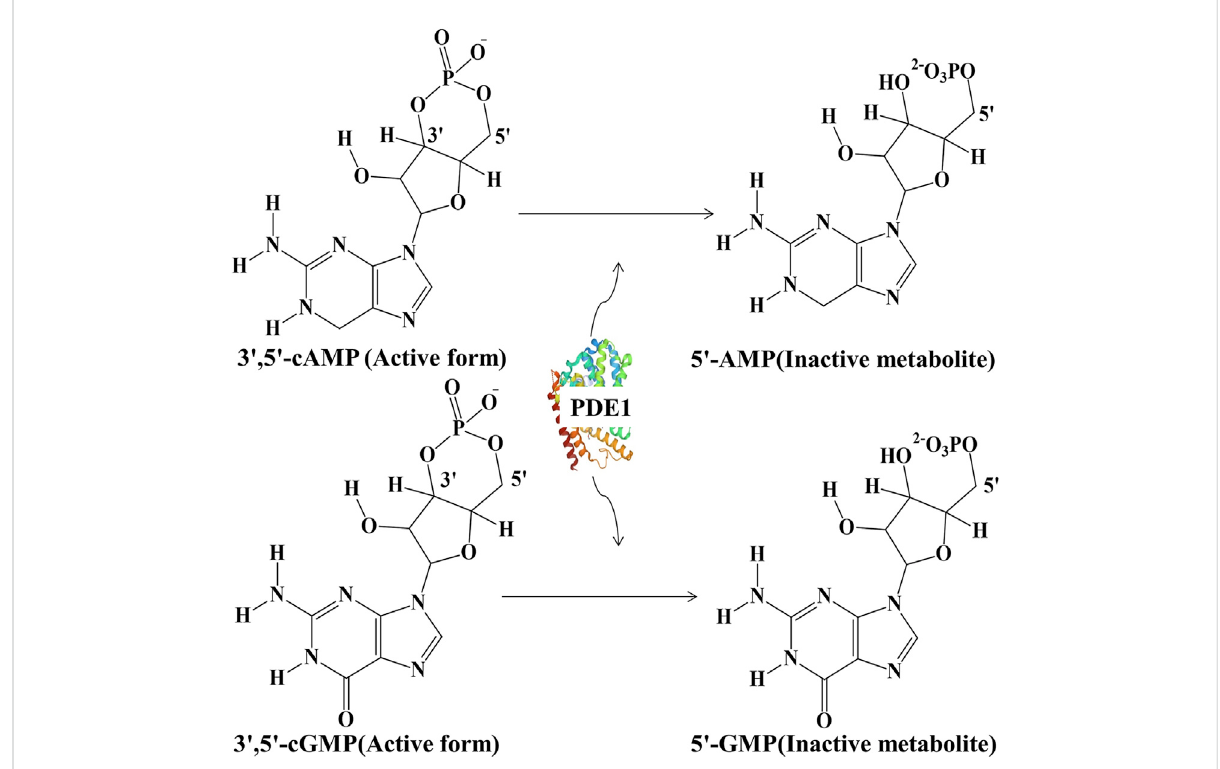
FIGURE 1 Hydrolysis of active 3 ʹ ,5 ʹ -cAMP into inactive 5 ʹ -cAMP and active 3 ʹ ,5 ʹ -cGMP into inactive 5 ʹ -cGMP by